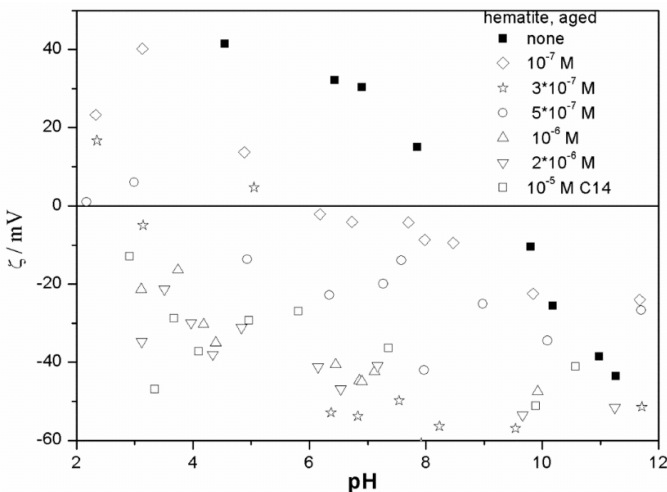
Figure 1. The ζ potential of hematite in aged dispersions in the presence of sodium tetradecylsulfate.